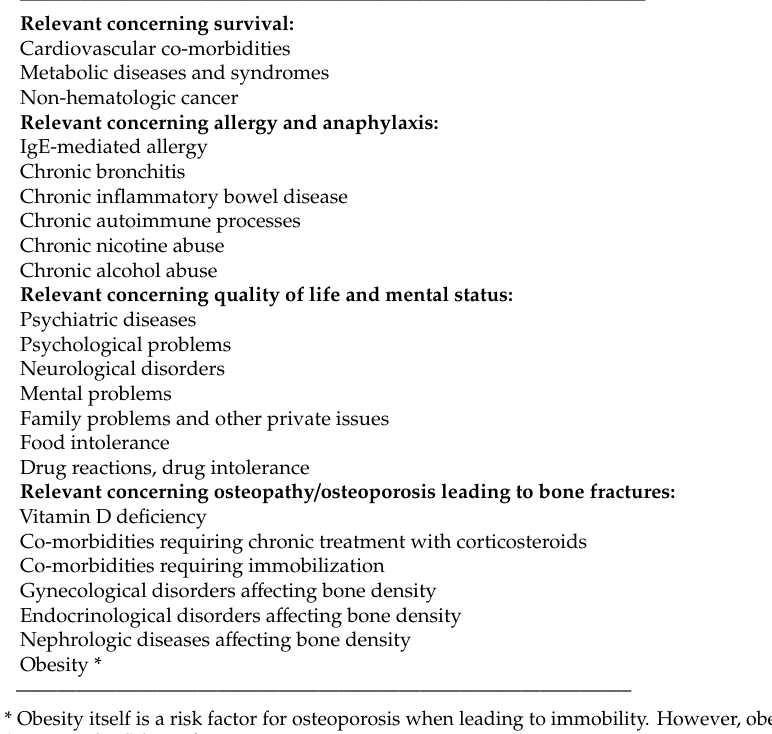
Table 3. Relevant co-morbidities in patients with systemic mastocytosis